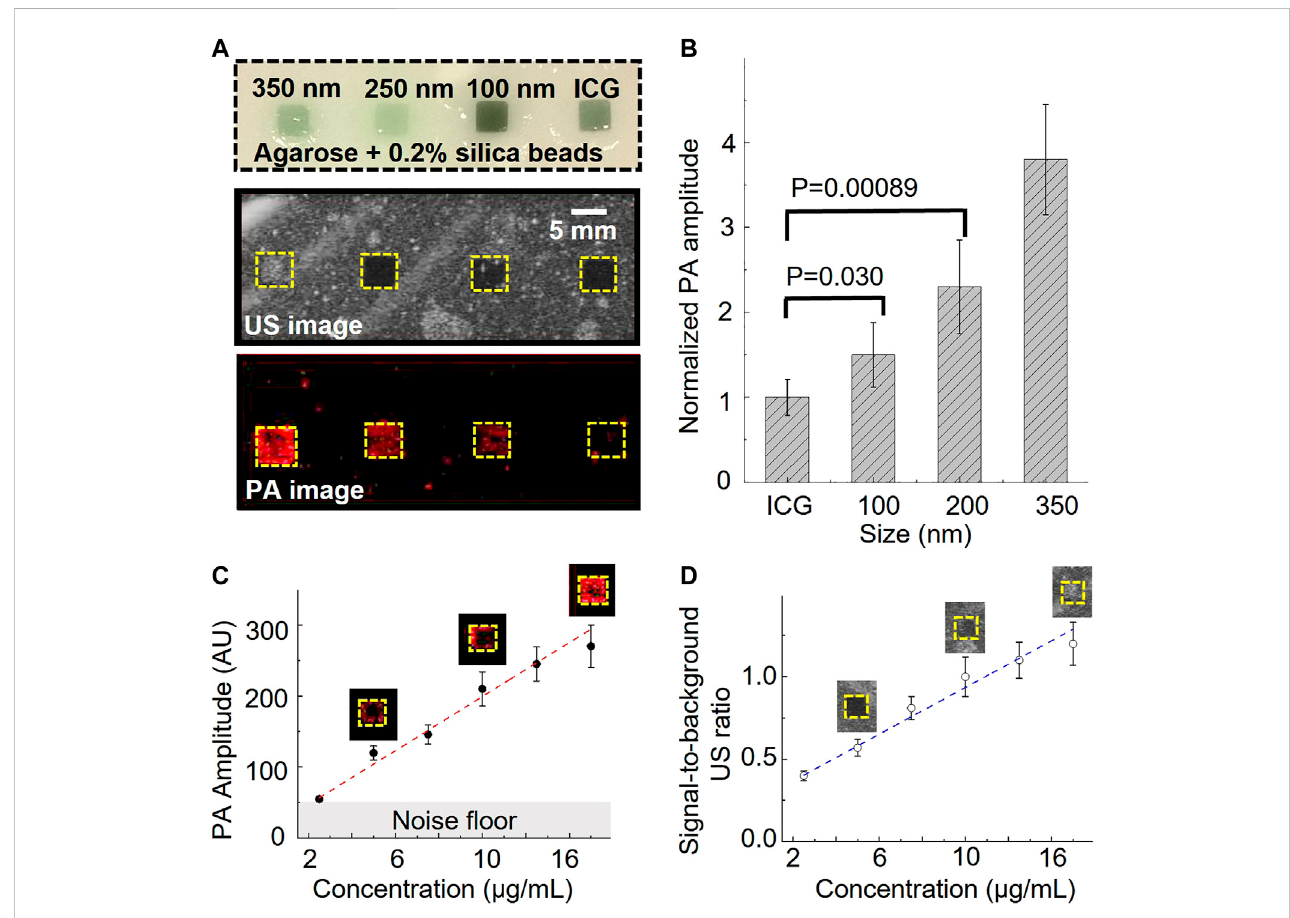
FIGURE 2 Photoacoustic/ultrasound signal characterization of ICG nanobubbles. (A) Ultrasound/photoacoustic image of 350 nm ICG nanobubbles, 250 nm ICG nanobubbles, 100 nm ICG nanobubbles and ICG solution. The four solutions were fi lled into the four inclusions of the agarose phantom, indicated by the pictureofagarosephantomonthetop.Allfoursolutionsmatchwiththesameopticaldensityat780 nm. (B) Quantitativecomparisonofphotoacoustic signal of different solutions (ICG, 100 nm ICG nanobubbles, 250 nm ICG nanobubbles, 350 nm ICG nanobubbles). Bar chart showing sample means (n = 10) withstandard-deviationerrorbars. (C) PAsignalasafunctionofICGnanobubbleconcentration.350nmICGnanobubbleswereusedandthecurveshowsPA signal is propositional to the bubble concentration. Bar chart showing sample means (n = 10) with standard-deviation error bars. (D)